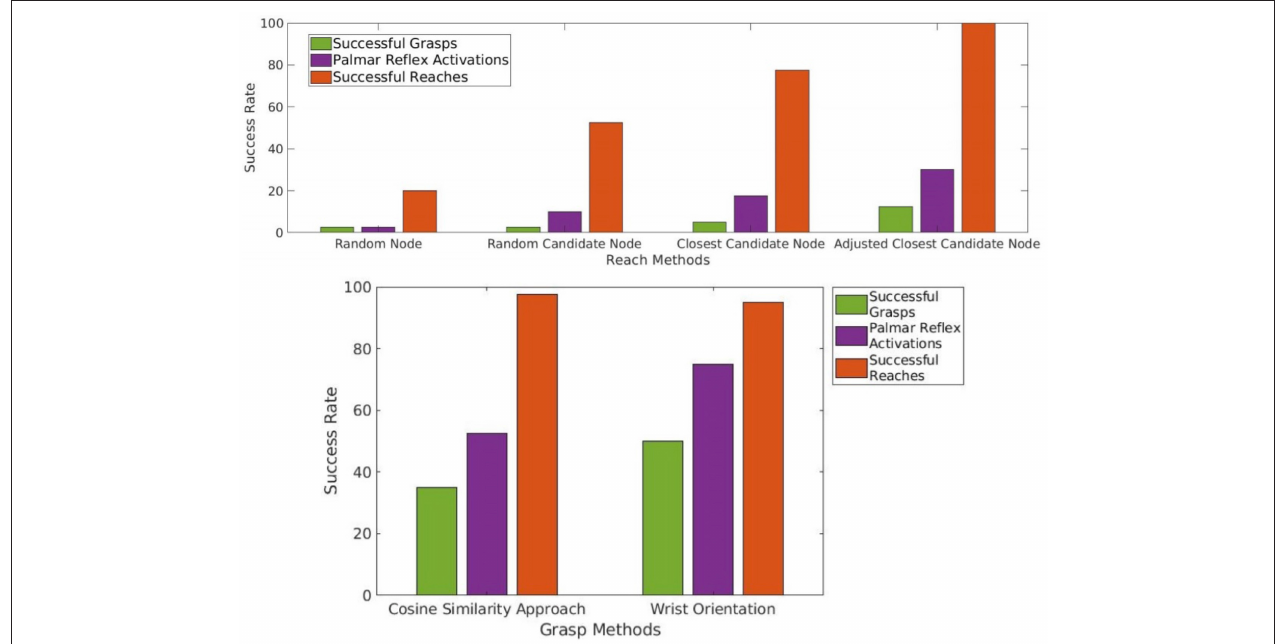
FIGURE 11 | The top plot presents the overall results from the reaching methods as a baseline for the grasp action as found in Experiment 8. The final reach method, Adjusted Closest Candidate Node (Experiment 7), is always successful at reaching, but within these interactions only 12.5% are fully successful though accidental grasps. By considering additional features, the grasp methods in the bottom plot all achieve more than double this success rate for grasping with only modest decreases in reach reliability. The Cosine Similarity Approach Method (Experiment 11) aims to increase the number of Palmar Bumps, with n f chosen from the candidates such that | C ( E g f , E o ) | is minimized and with n p replaced by a preshaping position so that all other cosine similarities are 1. Approaching with a motion parallel to E